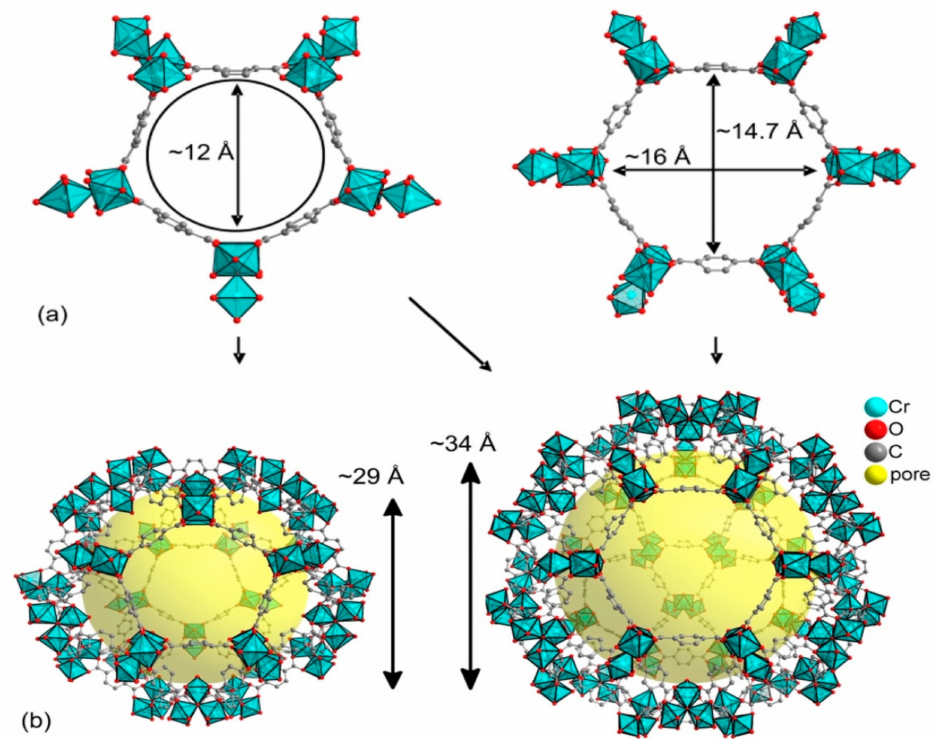
Figure 9. Trinuclear chromium building units and the bridging bdc ligands forming pentagonal and hexagonal rings ( a ) assembled into mesoporous cages ( b ) and mesoporous cages of yellow spheres with diameters of 29 or 34 Å, respectively. Reprinted with permission from Ref. [149]. Copyright 2016